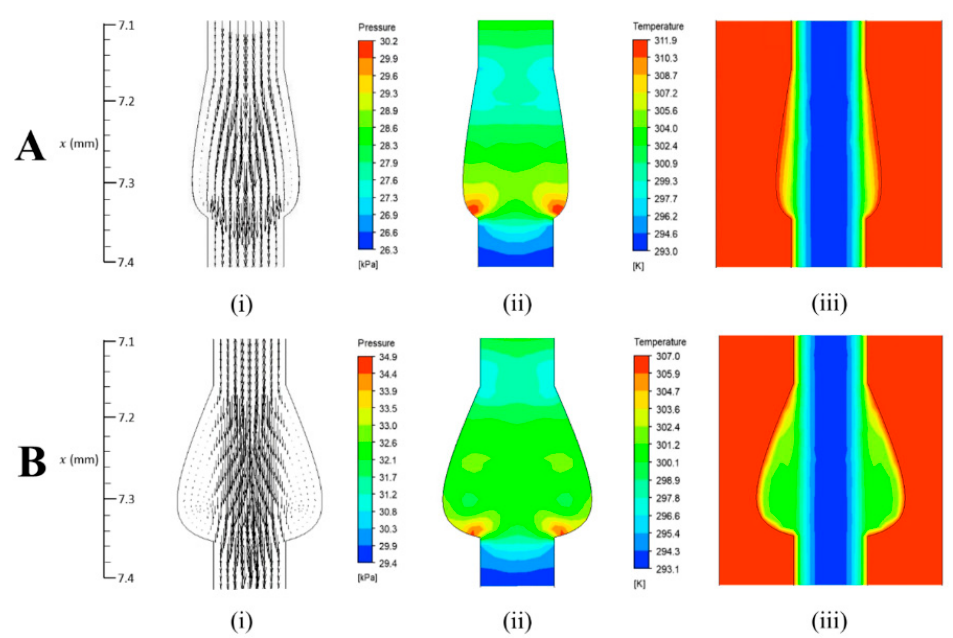
Figure 8. 𝜂 against 𝛾 . Figure 8. η against γ .